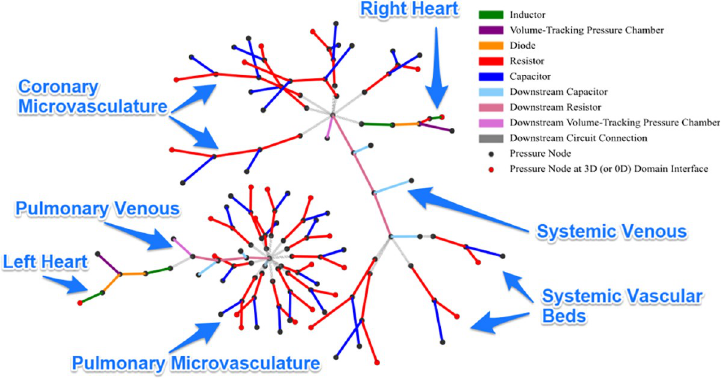
Fig 7. Visualisation of the Netlist boundary condition circuits shown in Fig 5. There are two connected components; during simulation, these two are joined by the two connected components of the 3D domain–the pulmonary arteries and the systemic arteries. Pressure nodes (between components) are shown as dots. Red dots indicate points of interface with the 3D domain. Lines indicate LPN components and are coloured according to type (resistor, capacitor,